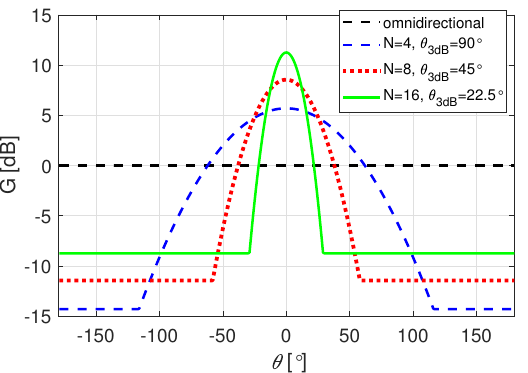
Figure 2. Antenna gain as a function of the offset angle θ . The directive beam patterns have beam- width of θ 3dB = 360 ◦ / N